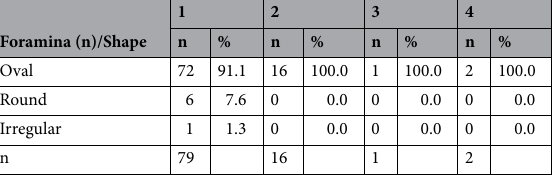
Table 5. Absolute and relative physiological foramina shape frequency of single-rooted mandibular canines (n = 98) according to the foramina number.